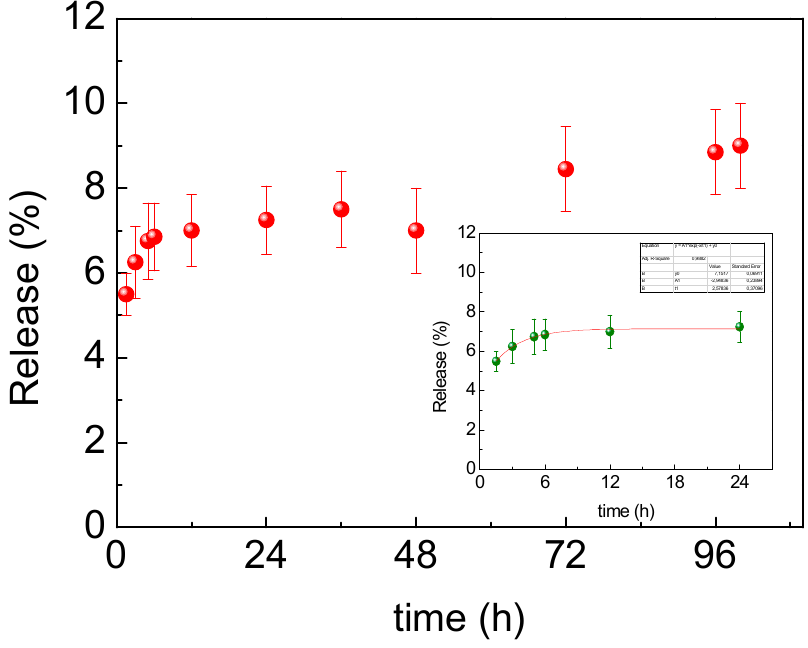
Figure 6. Released profile of AuNPs-A with inset details showing the release in time in the range of 0–24 h.